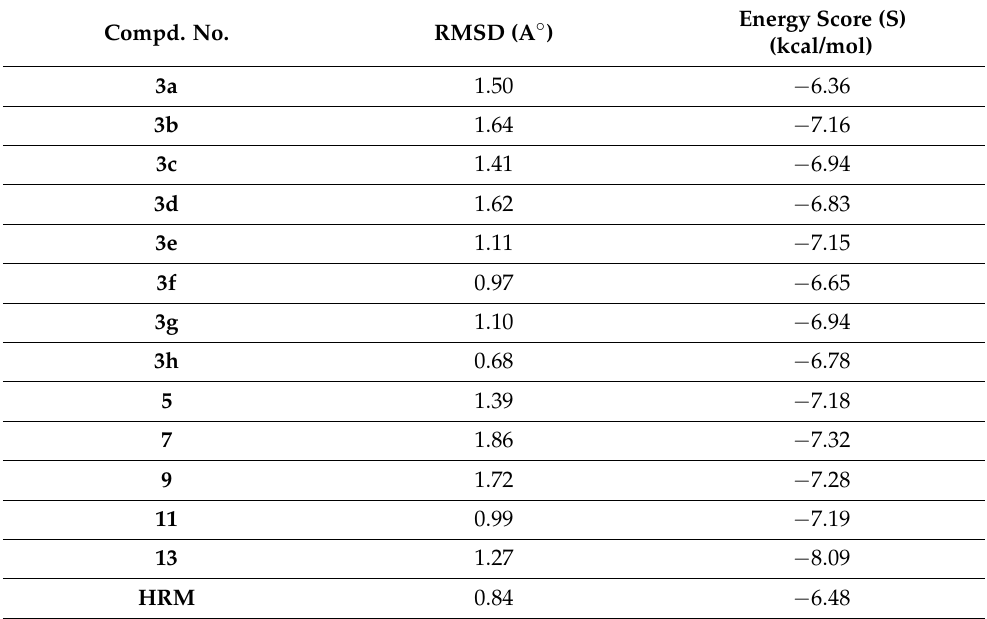
Table 2. RMSD (A ◦ ) and energy scores (kcal/mol) for azine derivatives ( 3a – h , 5 , 7 , 9 , 11, and 13 ) compared to the native ligand